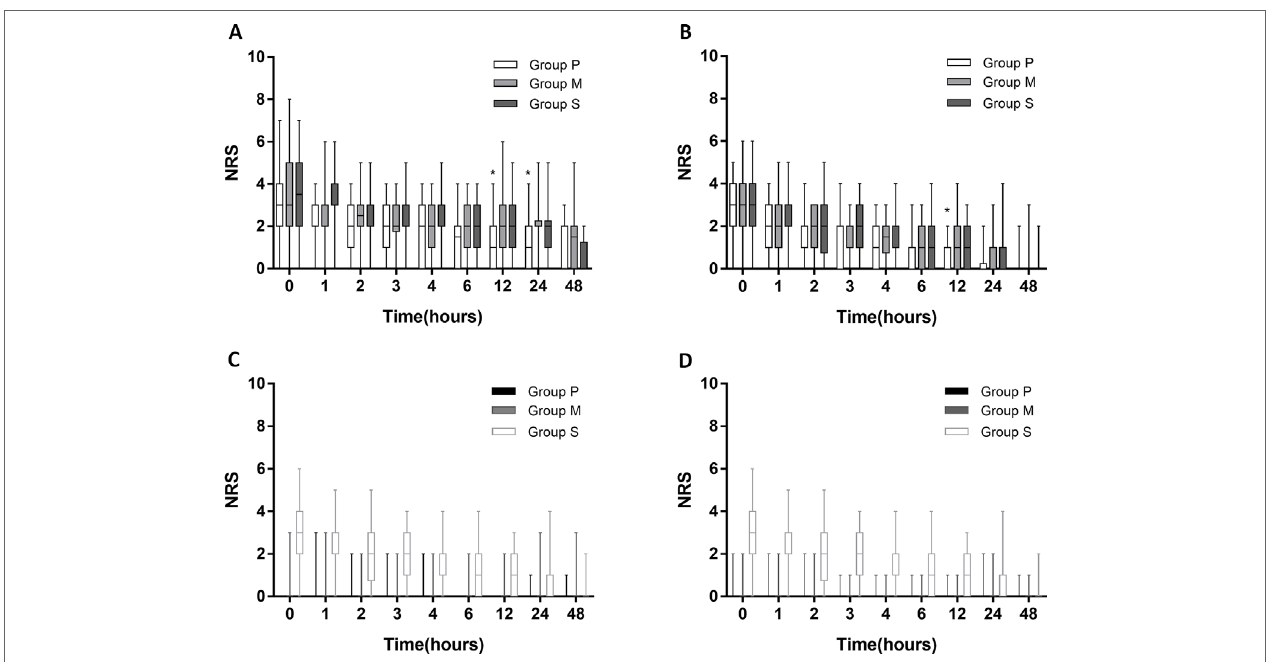
FIGURE 2 | NRS score following surgery. (A) NRS score of visceral pain intensity during coughing in 3 groups: parecoxib (Group P), methylprednisolone (Group M), and placebo (Group S). (B) NRS score of visceral pain intensity at rest. (C) incisional pain during coughing. (D) incisional pain at rest. Asterisks represented statistically significant difference between the groups: * p < 0.05.